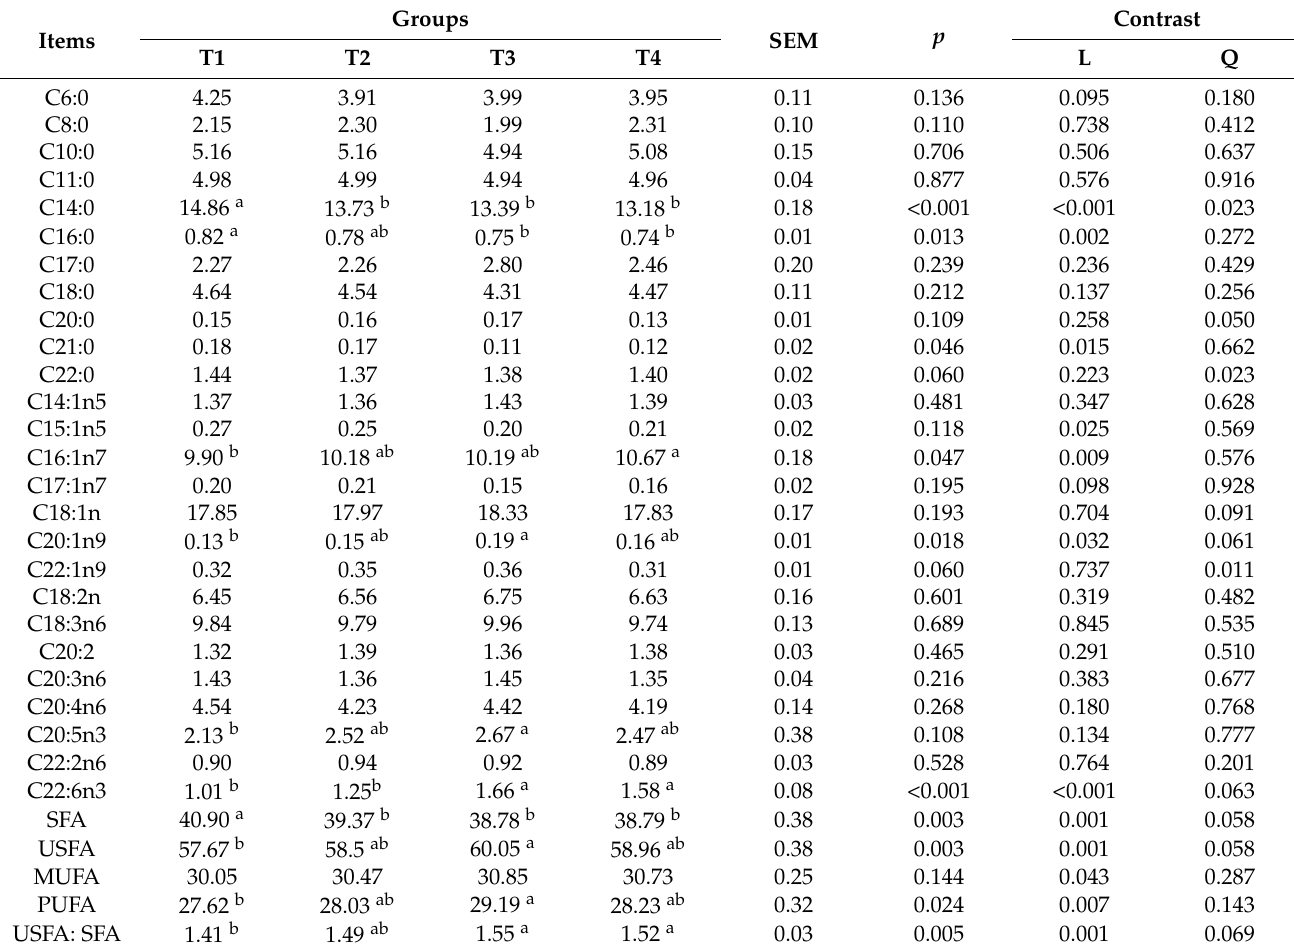
Table 5. Fatty acids profile in the breast muscle of broilers